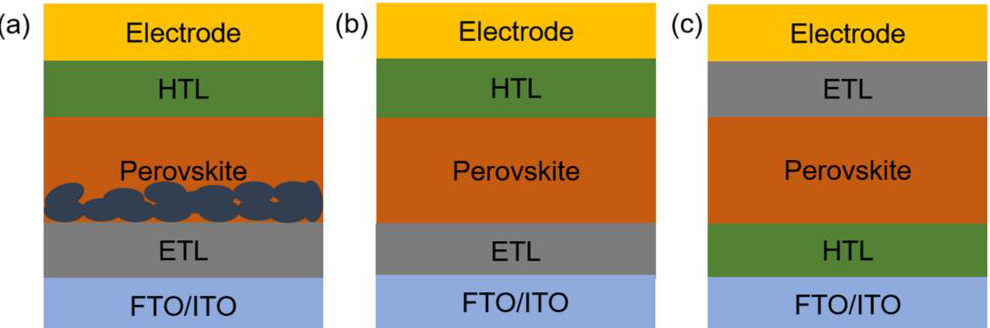
Figure 1. Schematic diagrams of PSCs with different configurations. ( a ) mesoporous n − i − p struc- ture; ( b ) planar n − i − p structure; ( c ) planar p − i − n structure.